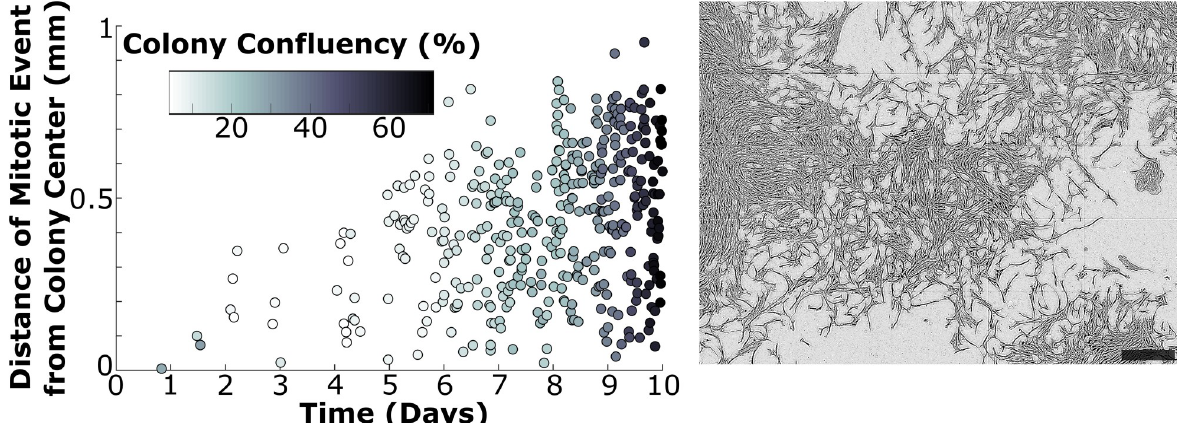
Fig 6. Proliferation continues to occur within confluent colonies. The time and location of each cell division–as well as colony confluency–was measured for the first ten days of colony development in one colony. Mitotic events are reported in terms of their location relative to the colony center at each time point, and the shade of the data points is representative of the measured colony confluency (left). Cells continued to proliferate even at the center of the confluent colony after ten days of development. A phase contrast image of the colony at the final time point is provided (right) as a reference point of the measured confluency. Analysis of a second colony is provided in S6 Fig. Scale bar = 0.5 mm.